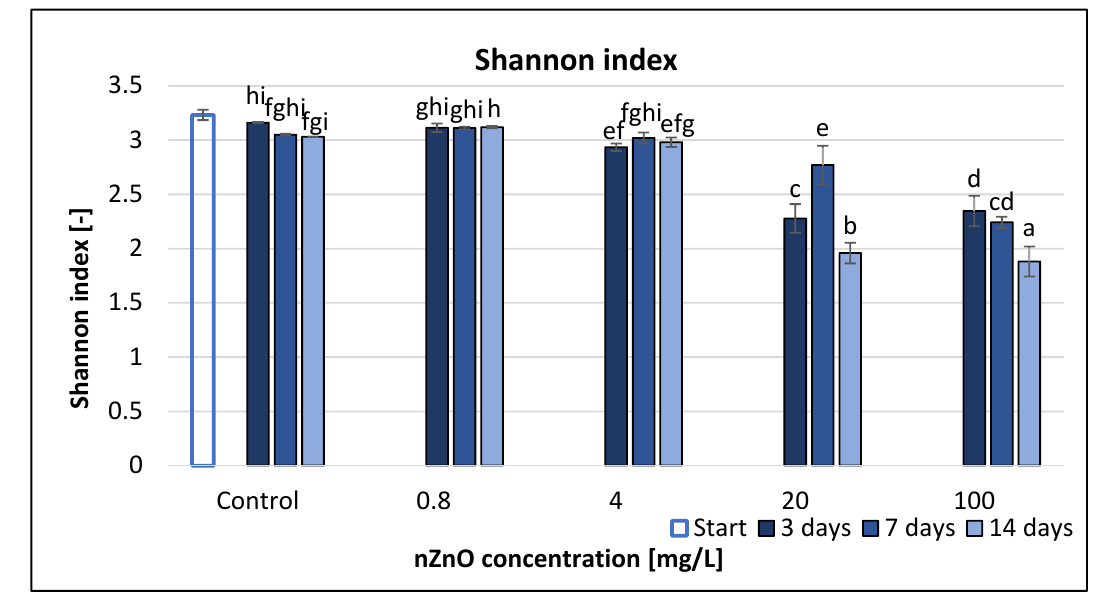
Figure 4. The effect of ZnO nanoparticles on freshwater Shannon index value. Letters on the columns indicate significant differences (level of significance: p < 0.05).